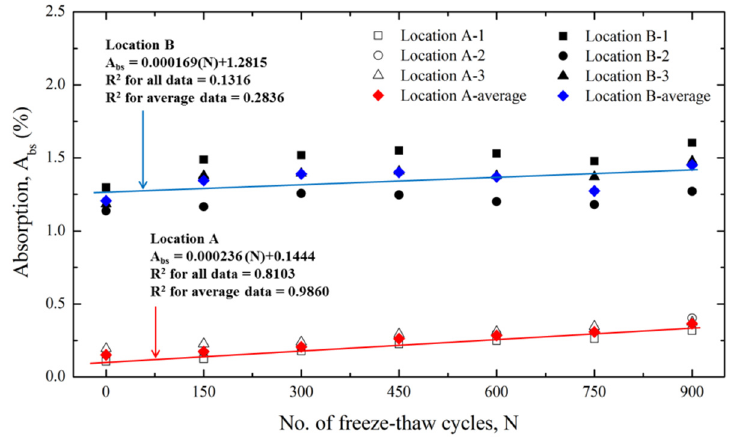
Figure 10. Absorption changes with increasing freezing-thaw cycle of locations A and B.